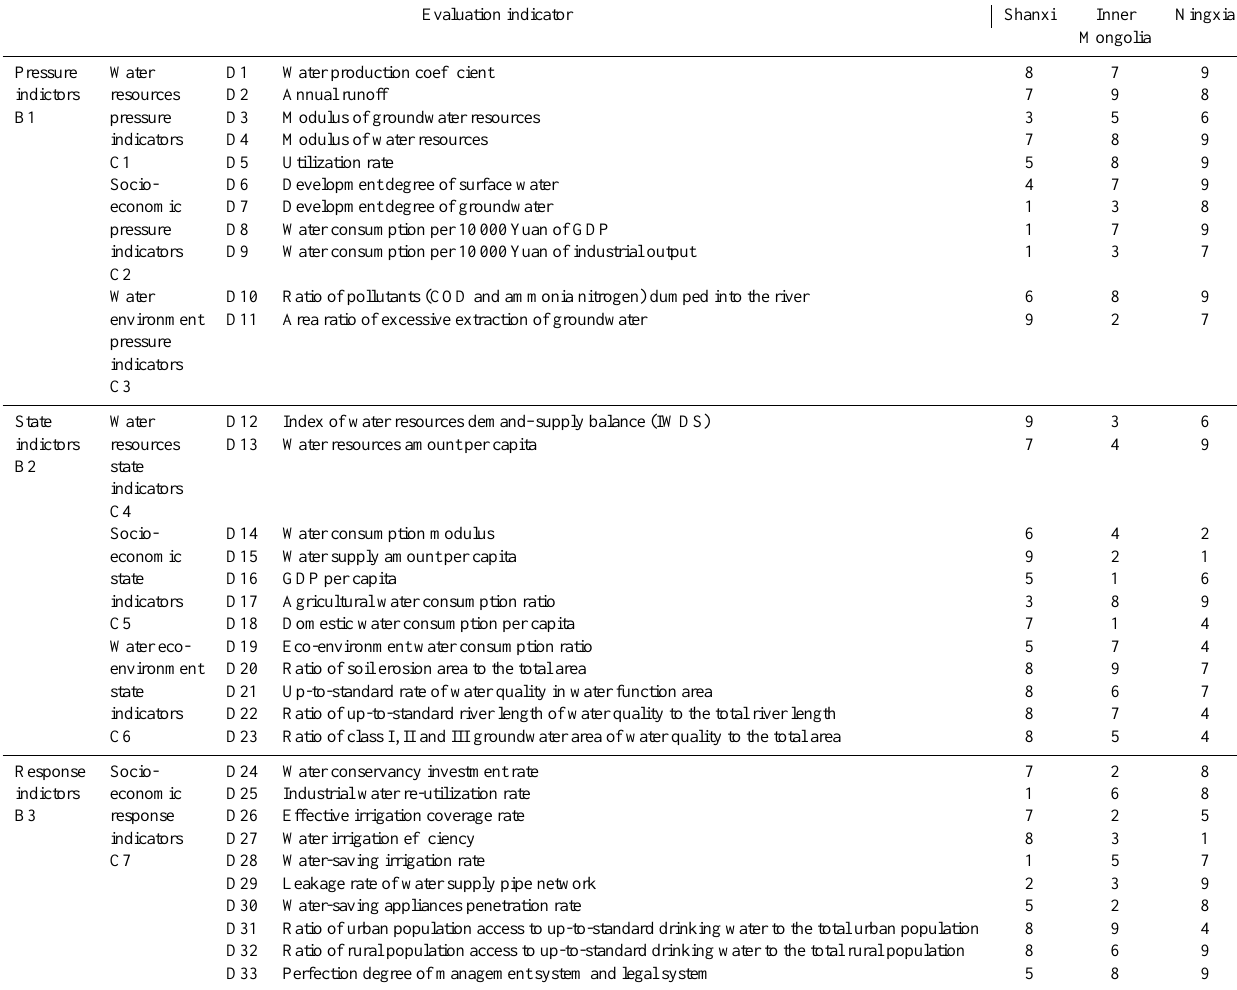
Table 11. Ranking results of indicator values in Shanxi, Inner Mongolia and Ningxia provinces. Evaluation